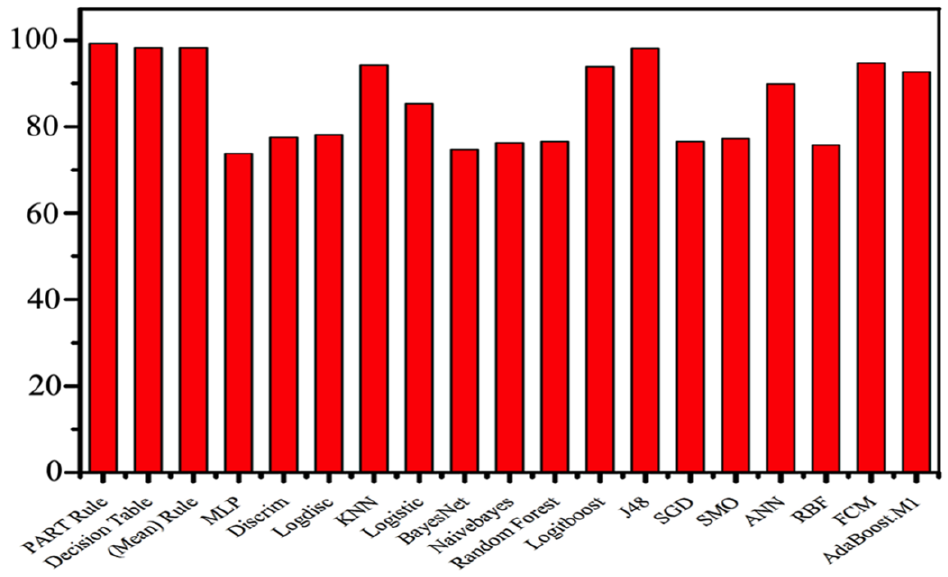
Figure 6. Comparisons of the rule classifier with other machine learning classifiers.